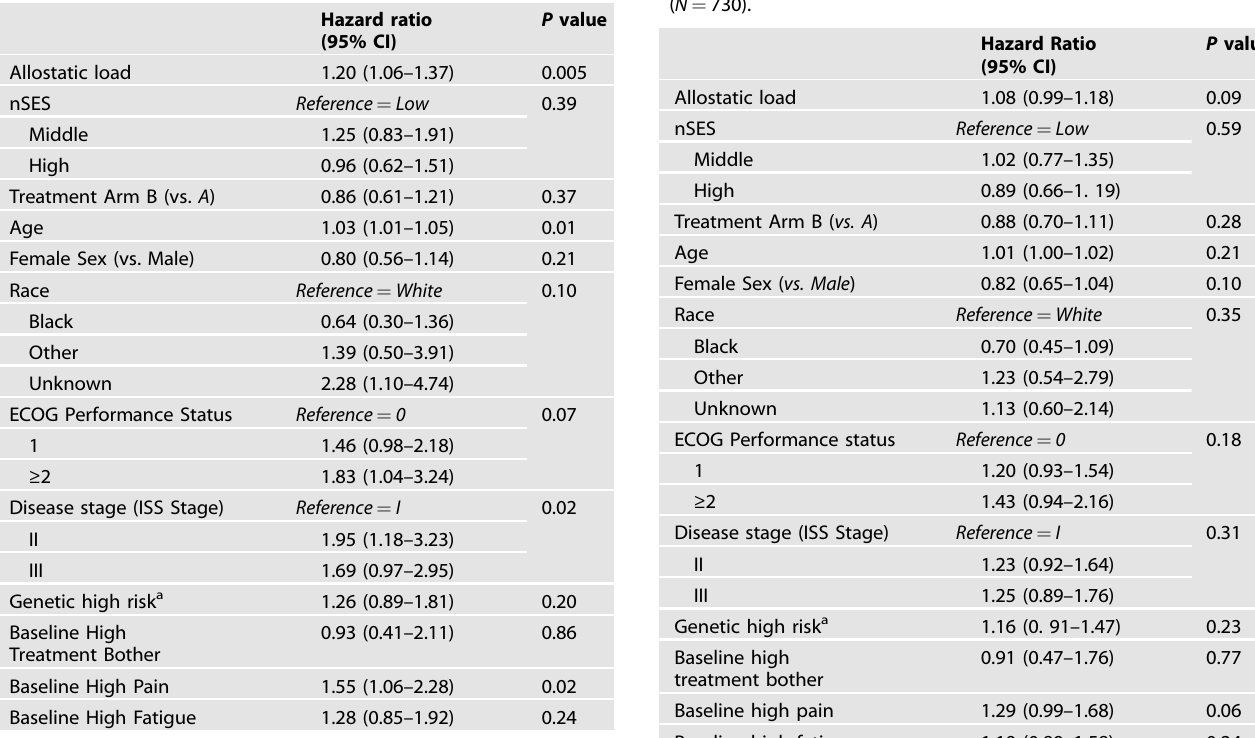
Table 3. Multivariable Cox regression for overall survival ( N = 730). Table 4. Multivariable Cox regression for progression-free survival